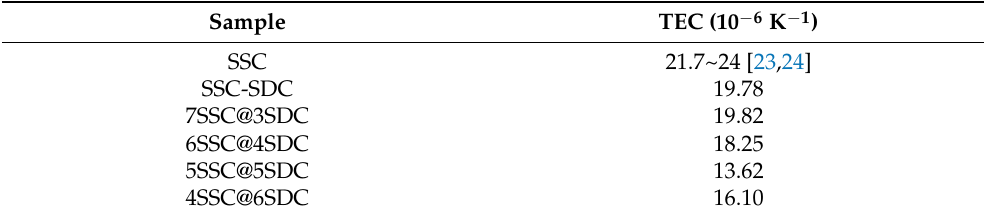
Table 1. Specific average TEC values for SSC-SDC, 7SSC@3SDC, 6SSC@4SDC, 5SSC@5SDC,